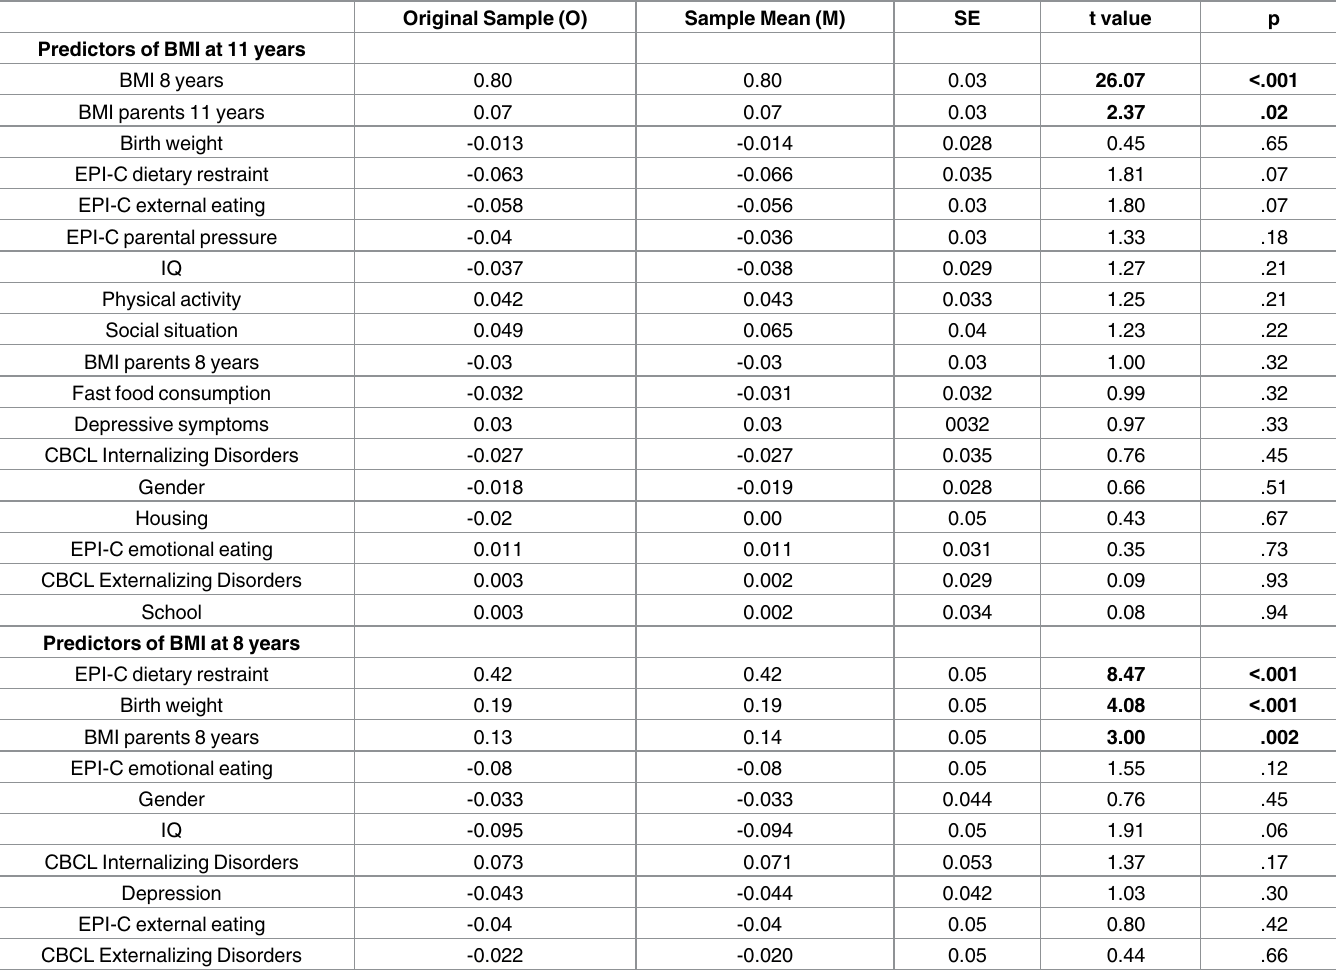
Table 3. Path coefficients of latent constructs predicting either children´s BMI at age 8 or children´s BMI at age 11. Significant t values after boot- strappingare printed in